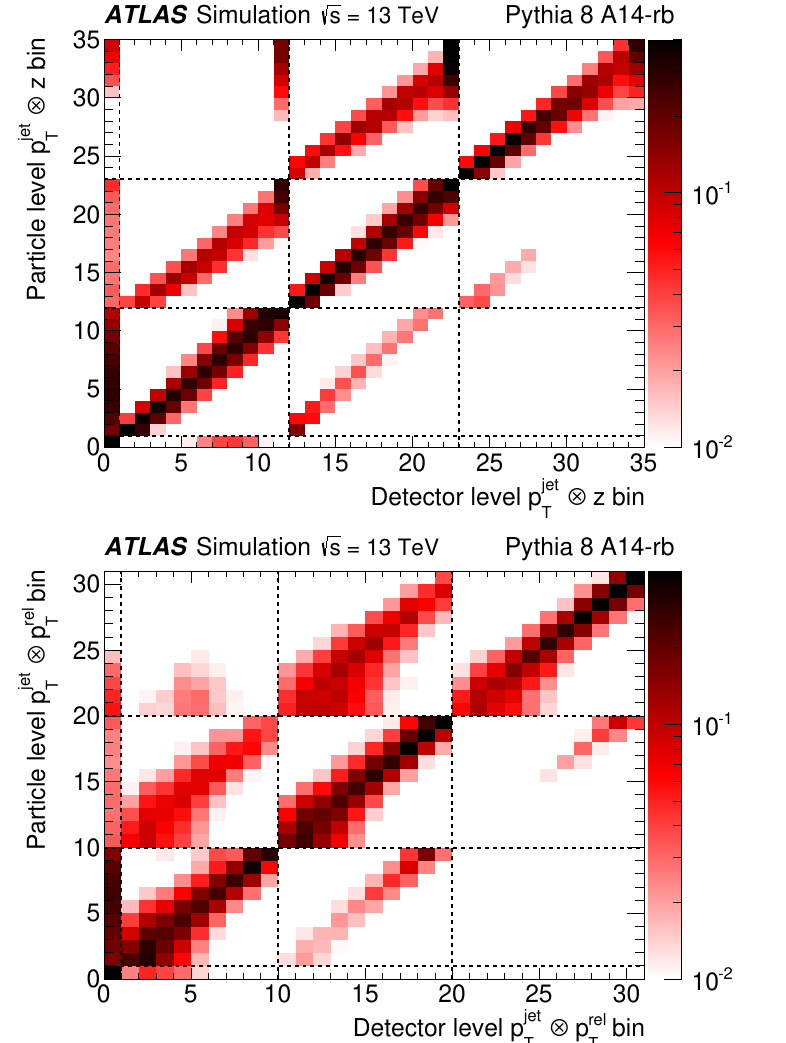
Figure 4 . Transfer matrices, obtained using the Pythia 8 A14-rb MC sample, as a function of the jet p and the longitudinal profile z (top) and the transverse profile p rel T square represents a bin in ( p ) or ( p ) , while each large box represents one of the three jet- p rel T , z T , p T intervals used in the analysis. The first bin, containing jets with p